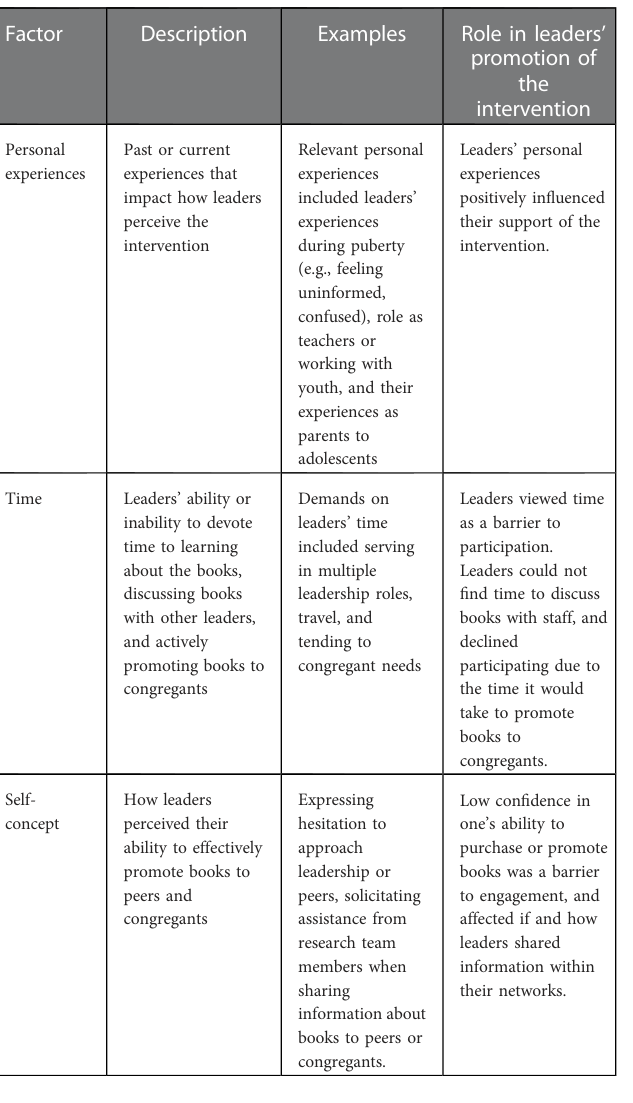
TABLE 1 The impact of individual-level factors on church leaders ’ promotion of puberty books.